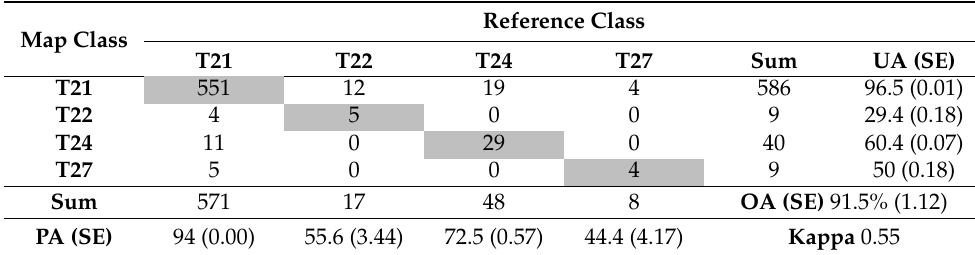
Table 7. Confusion matrix of RF result for the needleleaved forest habitat type EUNIS III level classification. T31: temperate mountain Picea forest, T32: temperate mountain Abies forest, T33: mediterranean mountain Abies forest, T34: temperate subalpine Larix , P. cembra and P. uncinate forest, T36: temperate and sub-mediterranean montane P. sylvestris – P. nigra